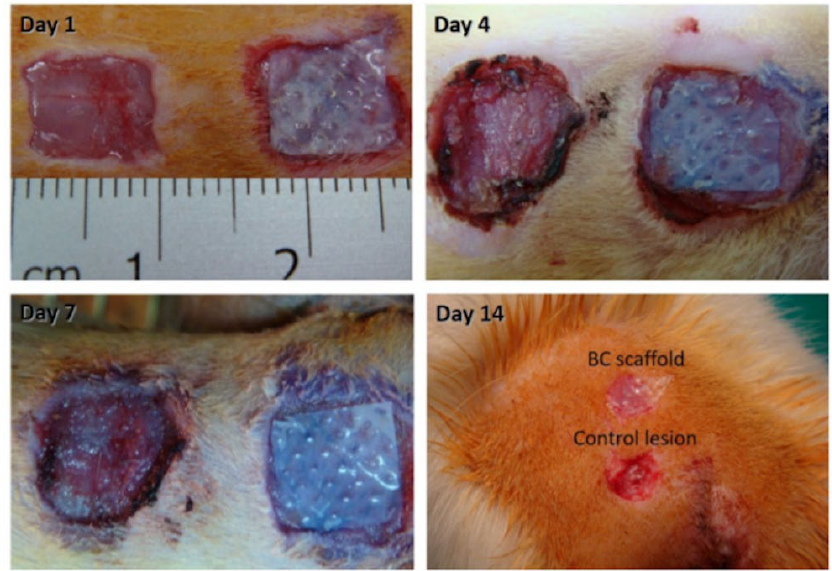
Figure 11. Rat model of skin defects healing over time without ( left side ) or with bacterial cellulose scaffold covering ( right side ) (Adapted from Cheng et al. [188]).